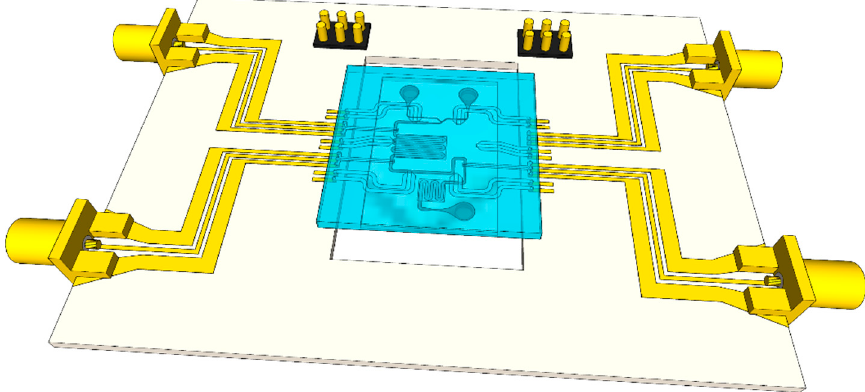
Figure 5. Illustration of the microwave-microfluidic platform with the microwave-microwave chip.